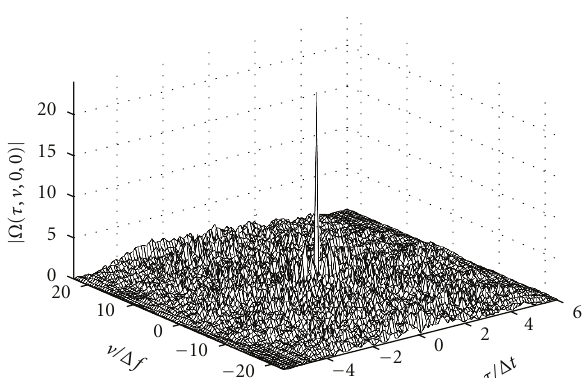
Figure 6: | Ω ( τ , ν ,0,0) | for the code whose hit-matrix is shown in Figure